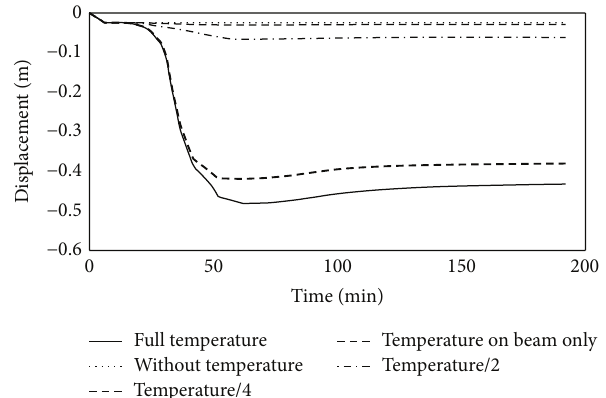
Figure 18: Out-of-plane buckling of the beam web for connection to the bolted T